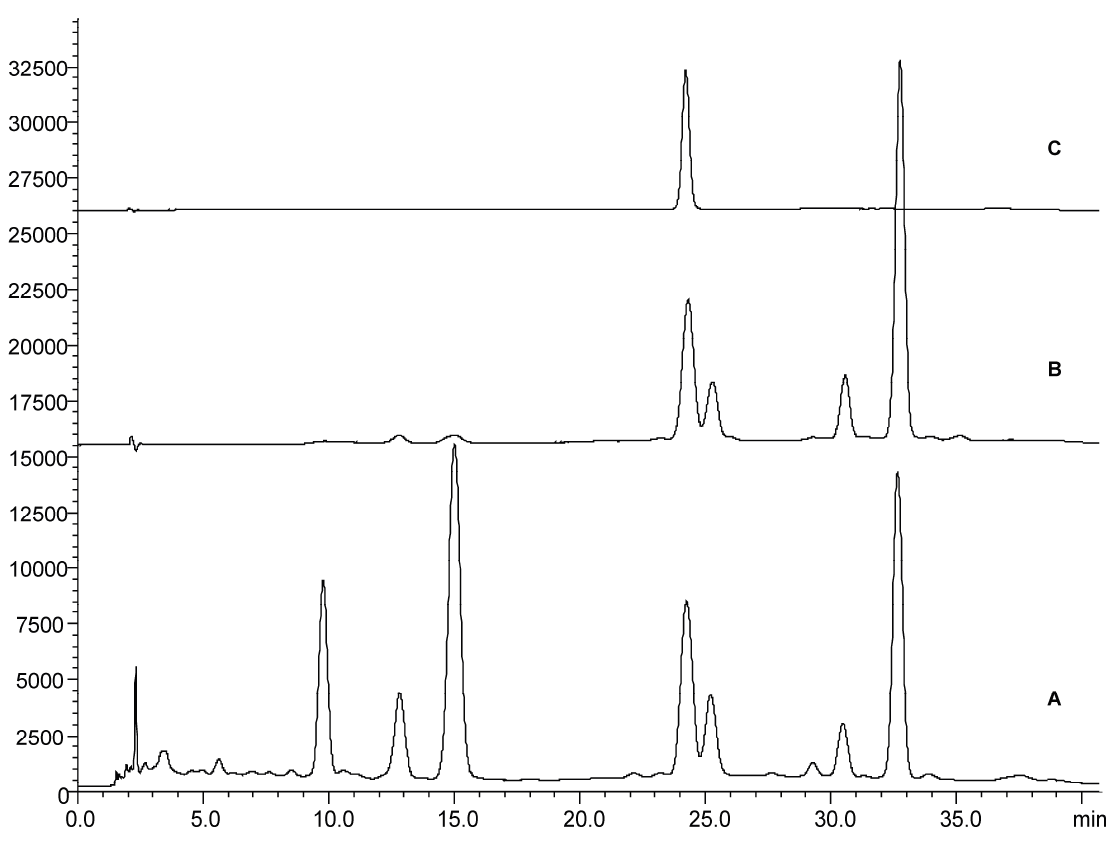
Figure 1. HPLC chromatograms of ( A ) aqueous extract ( B ) n -hexane fraction; and ( C ) 5-methoxy-6,7-methylenedioxycoumarin isolated from P. balansae